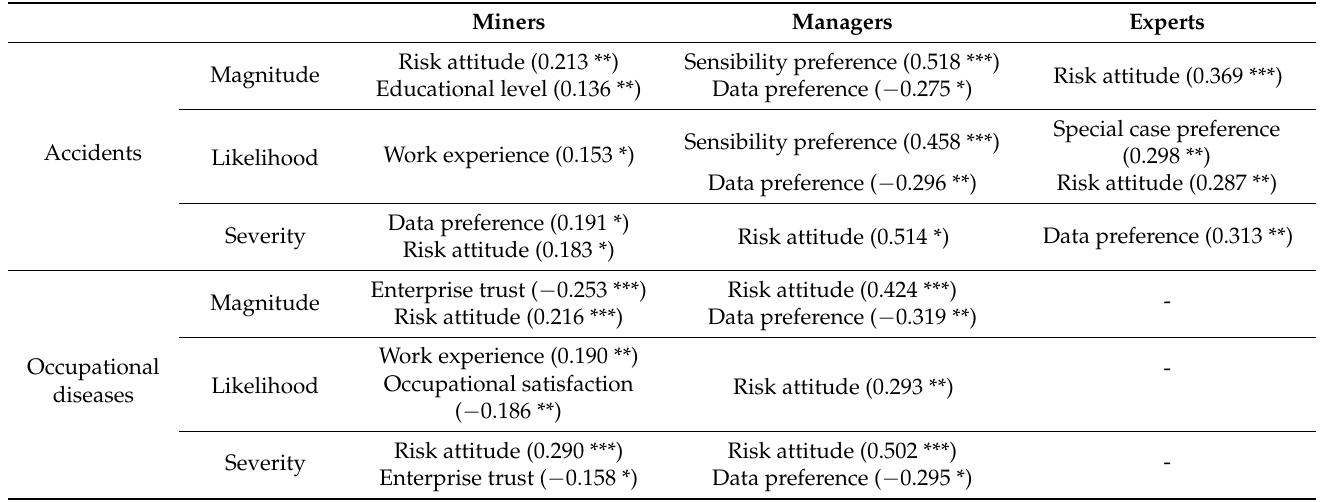
Table 9. Important predictors of different groups for the risk perceptions of accidents occupational